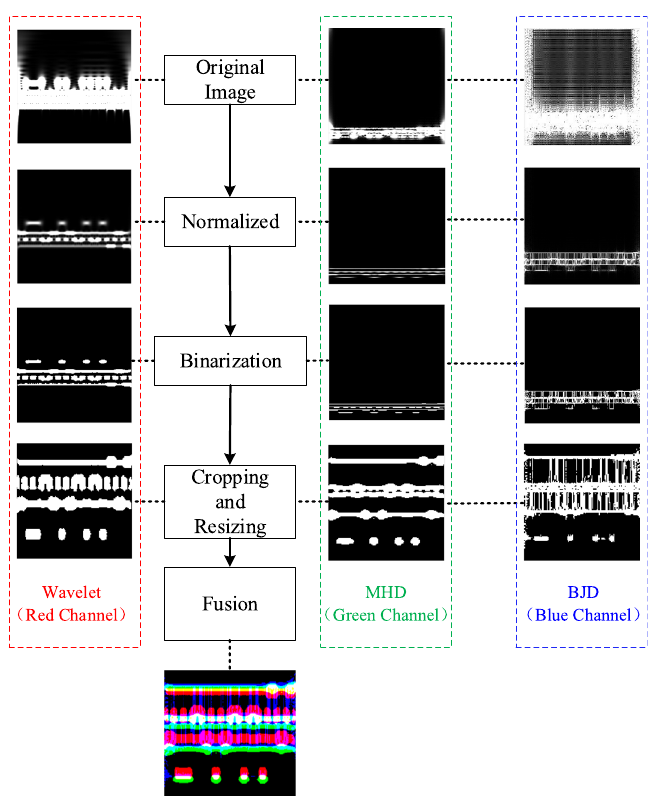
Fig. 2 Flowchart of composite time-frequency